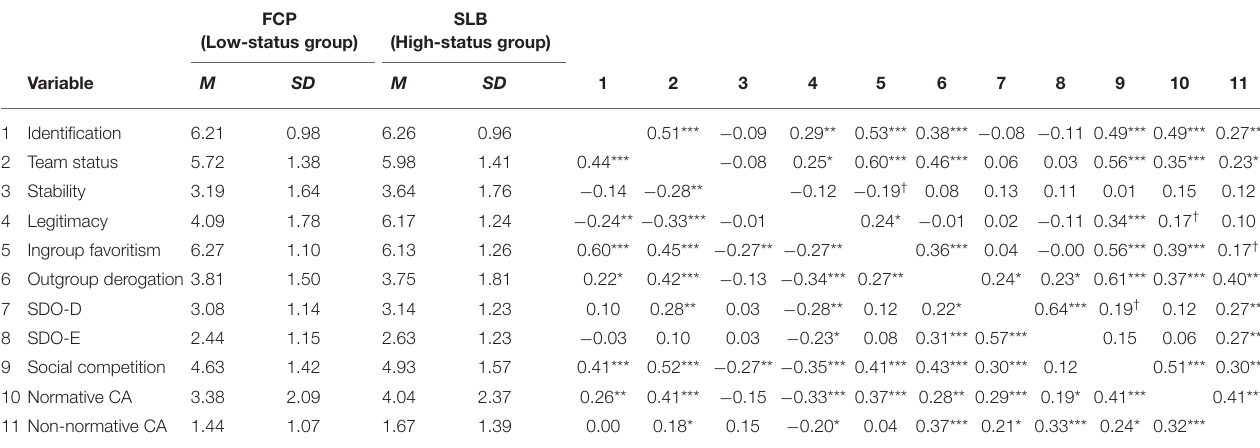
TABLE 2 | Summary of means, standard deviations, and correlations between measures by football team. FCP SLB (Low-status group) (High-status group) Variable